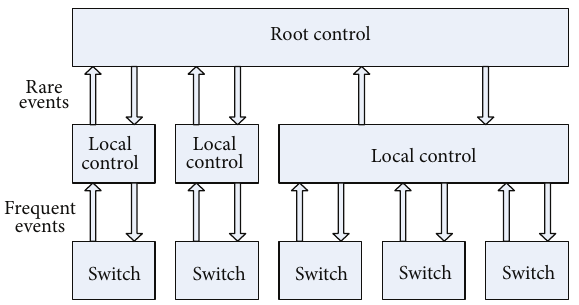
Figure 1: Kandoo two levels of controllers [4].